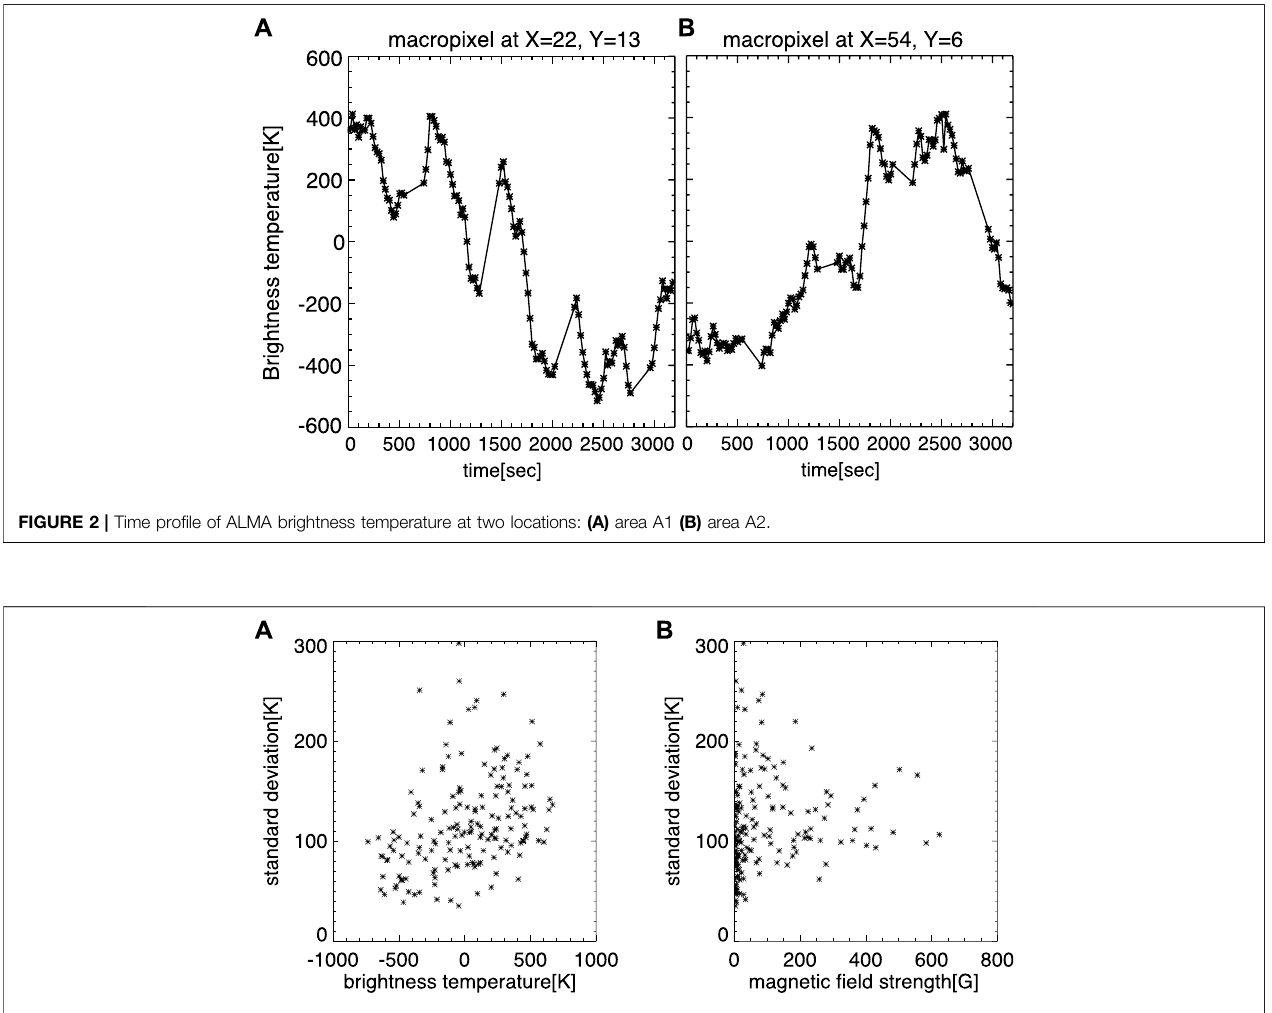
FIGURE3| The magnitude oftimevariationsmeasured asthestandarddeviation inthetime series ofALMA dataiscompared (A) tothetime-averaged brightness temperatureand (B) tothemagnetic fl uxdensityinthephotosphere.Thevalueofmagnetic fl uxdensity(magneticstrength)isderivedfromthemagnetic fl uxdensitymap binned to 4